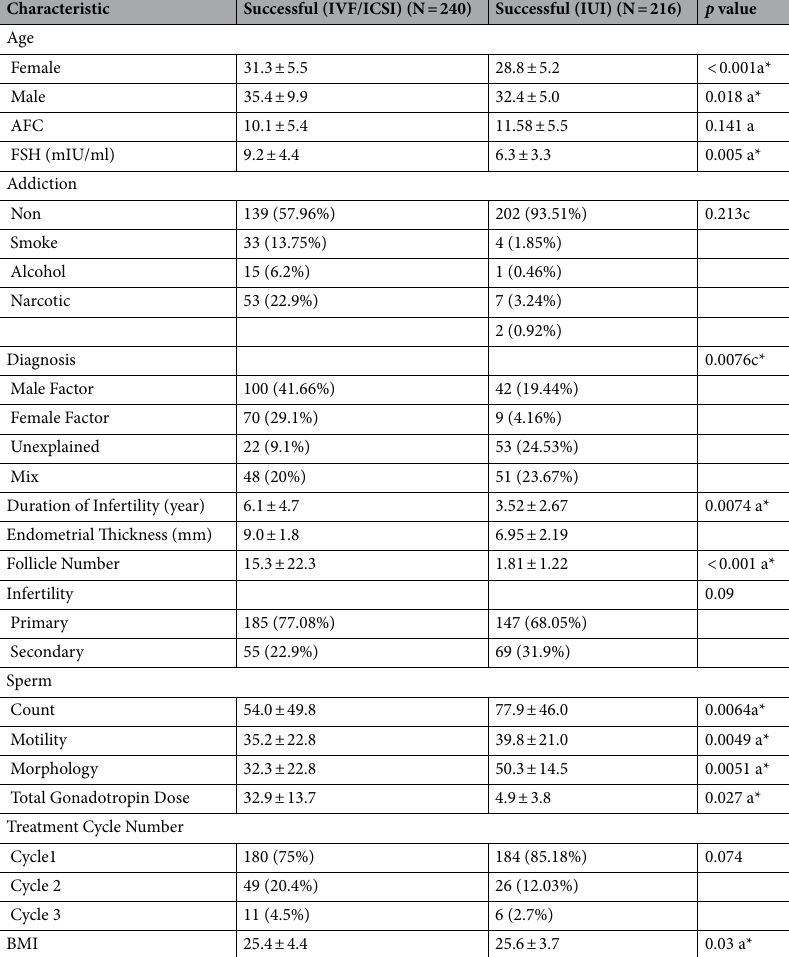
Table 2. Clinical characteristics of couples undergoing IVF/ICSI and IUI with common factors. AFC, Antral Follicle Count; FSH, Follicle Stimulating Hormone; BMI, Body Mass Index, Mean ± Standard Division for continues and N (%), percent of the number of couples for categorical variables are presented. *Significant features ( p value < 0.05). a Examined via Student’s t test. b Examined via Fisher’s exact test. c Examined via Chi- square